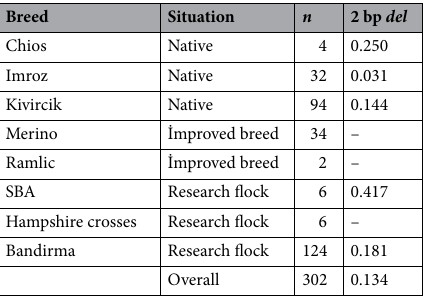
Table 1. Frequencies of the 2 bp del mutation in 151 matched pairs